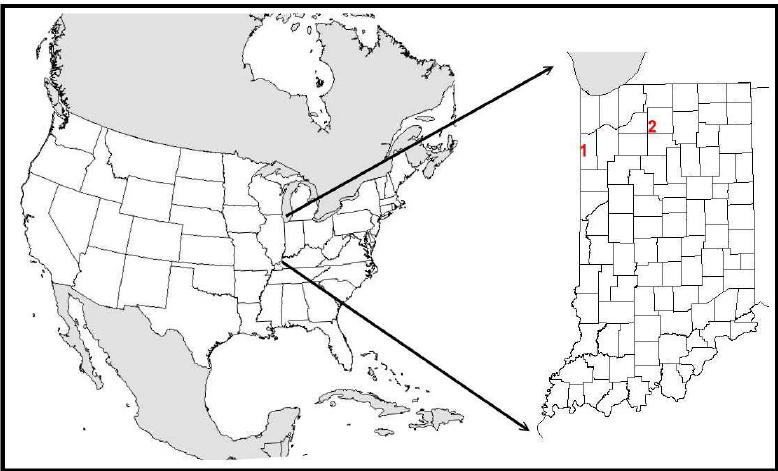
Figure 1. The locations of restorations at Kankakee Sands (1) and Houghton Lake (2). Both sites are located within the state of Indiana in North